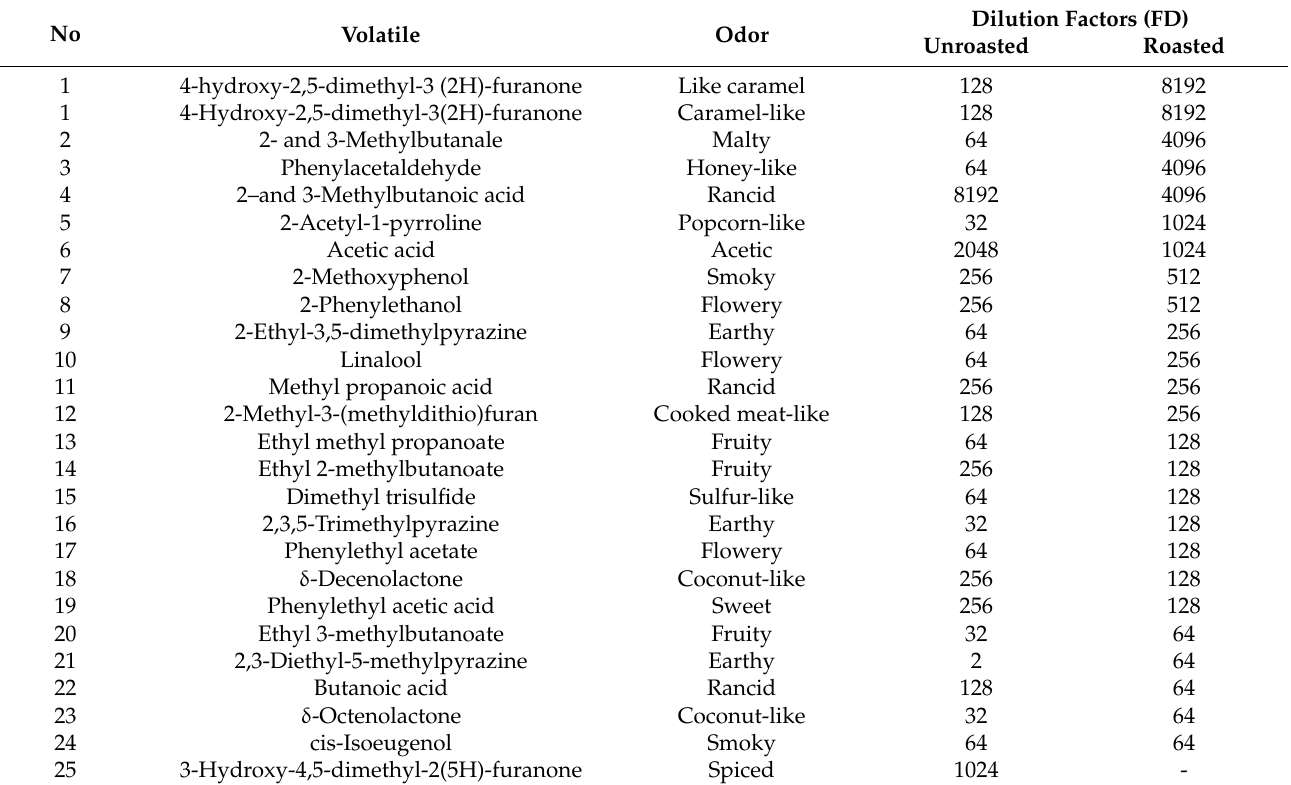
Table 1. Dilution factors of active odor compounds from roasted and unroasted forastero cocoa